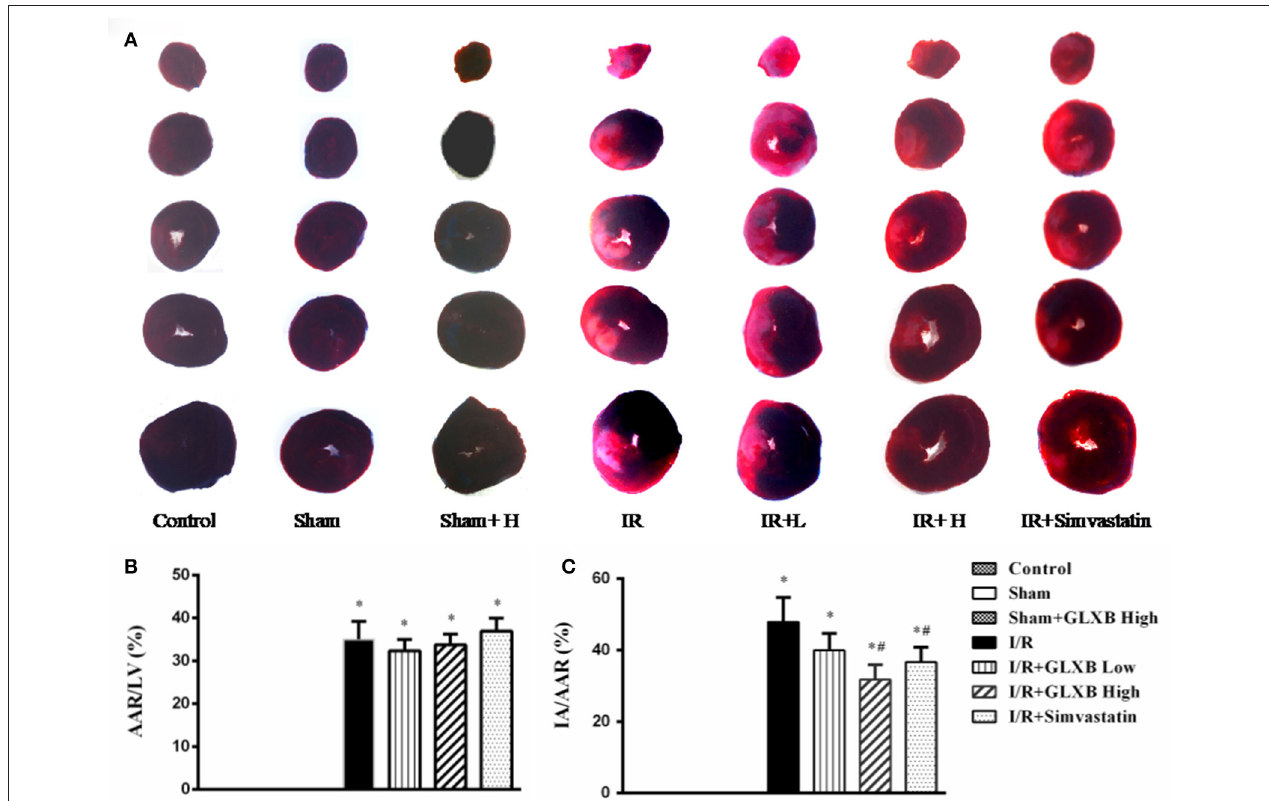
FIGURE 3 | The effect of GLXB on I/R-induced myocardial infarct size in rats. (A) Representative myocardial tissue slices of left ventricle stained by Evans blue-TTC in Control, Sham, Sham + GLXB High, I/R, I/R + GLXB Low, I/R + GLXB High, and I/R + Simvastatin. (B) Quantitative analysis of AAR/LV in various groups. (C) Quantitative analysis of IA/AAR in various groups. Data are mean ± SEM, n = 6. * P < 0.05 vs. Sham group, # P < 0.05 vs. I/R